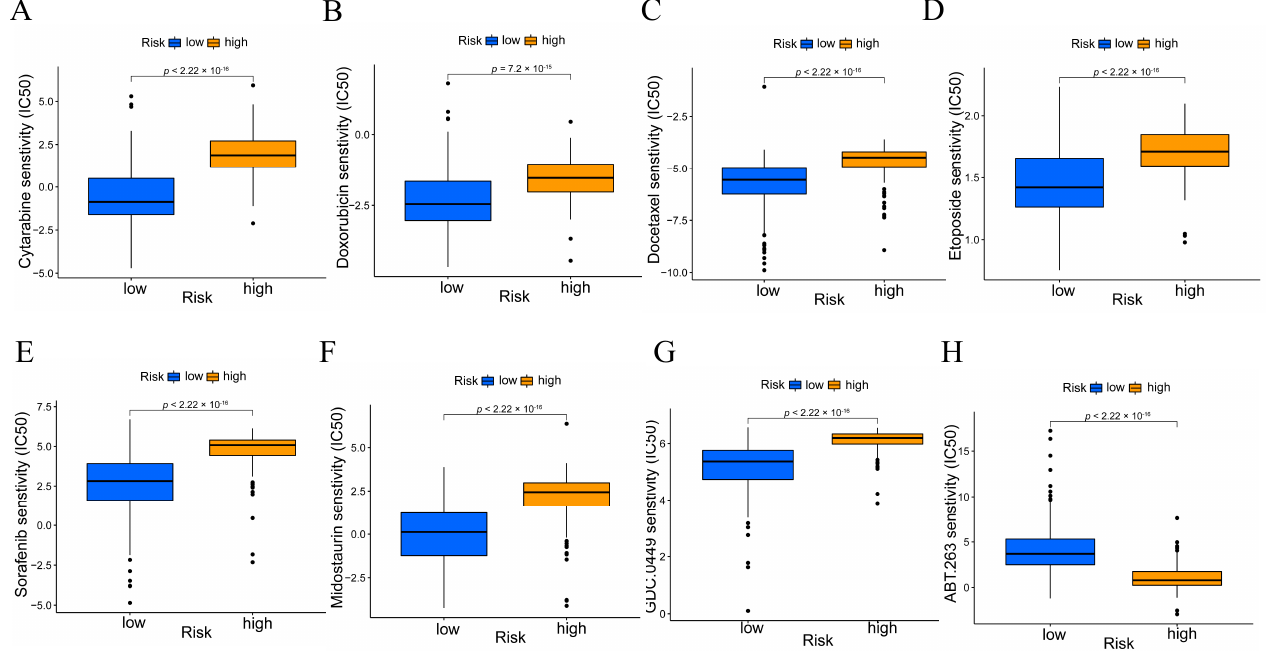
Figure 8. Expression comparison of immune checkpoint genes between different risk groups in the TCGA-TARGET cohort ( A ) and GEO cohort ( B ). * p < 0.05, ** p < 0.01, *** p < 0.001, and **** p < 0.0001.